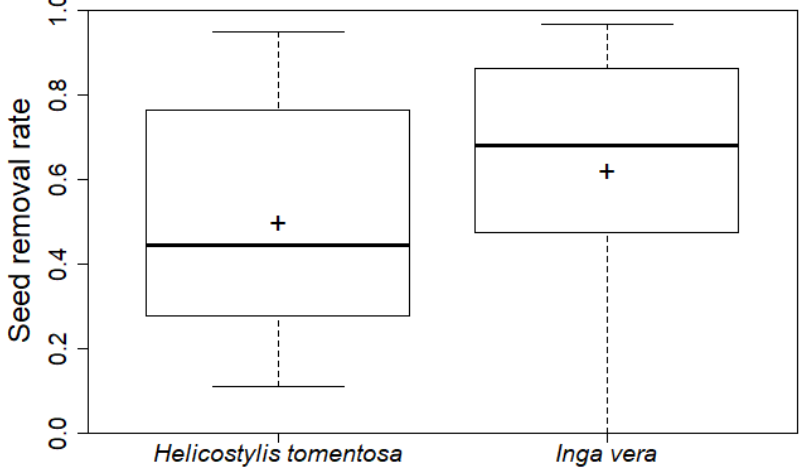
Figure 2. Boxplots of seed removal rates for each species with means (+).